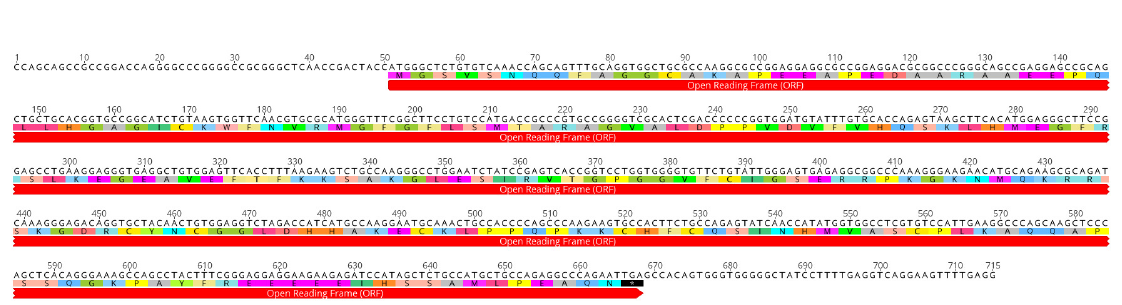
Figure 3. The nucleotide sequence and the deduced amino acids of Arabian camel Lin-28. The sequence was submitted to NCBI GenBank (accession number MK562530).